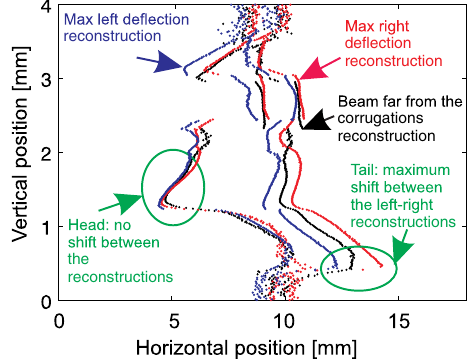
FIG. 7. Horizontal deflection of the bunch tail indicated by the horizontal shift of the centroids of double Gaussian fit. The blue dots are for the maximum left deflection, the red dots for the maximum right deflection and the black dots are for the undeflected beam, far from the corrugations. The bunch tail is clearly observed.